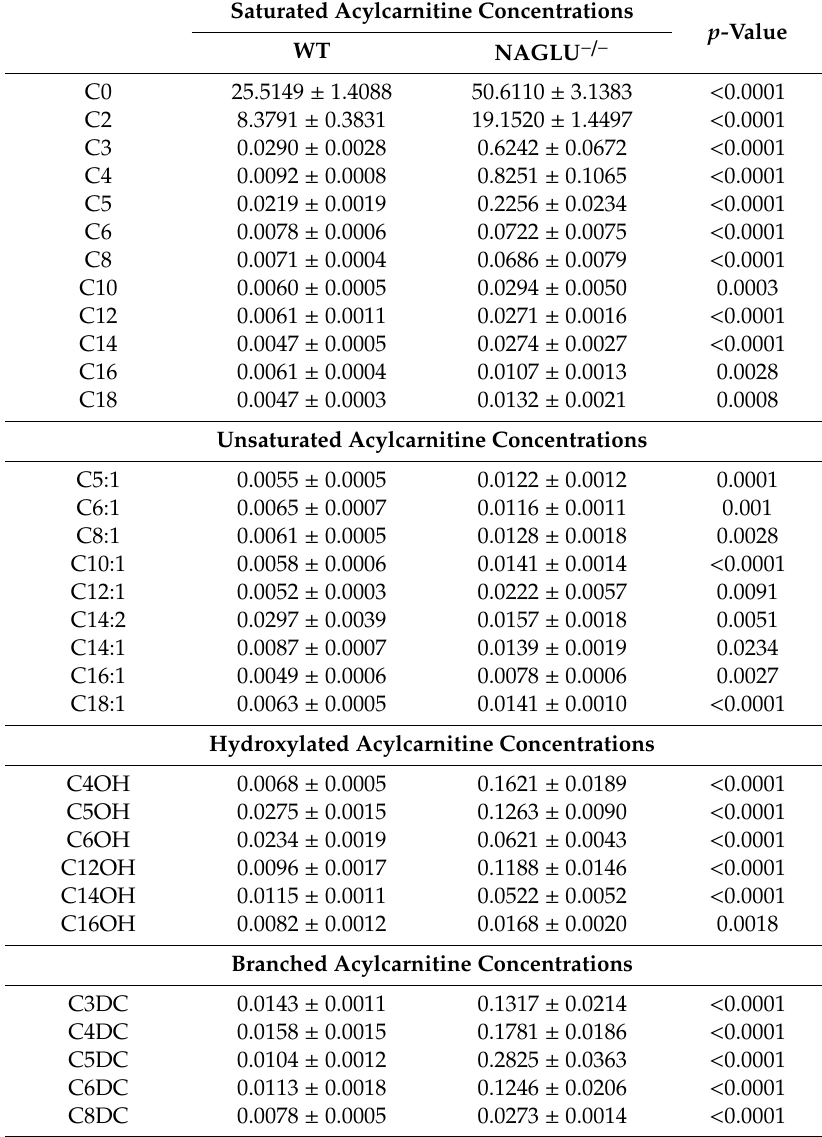
Table 4. Di ff erentially abundant metabolites in the